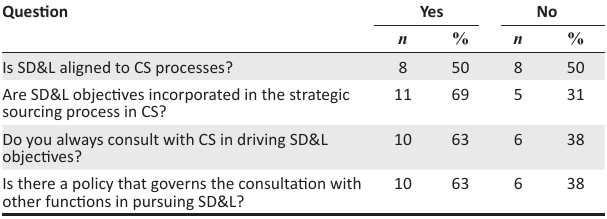
TABLE 1: Supplier Development and Localisation respondents’ perceptions of the relationship with Commodity Sourcing.